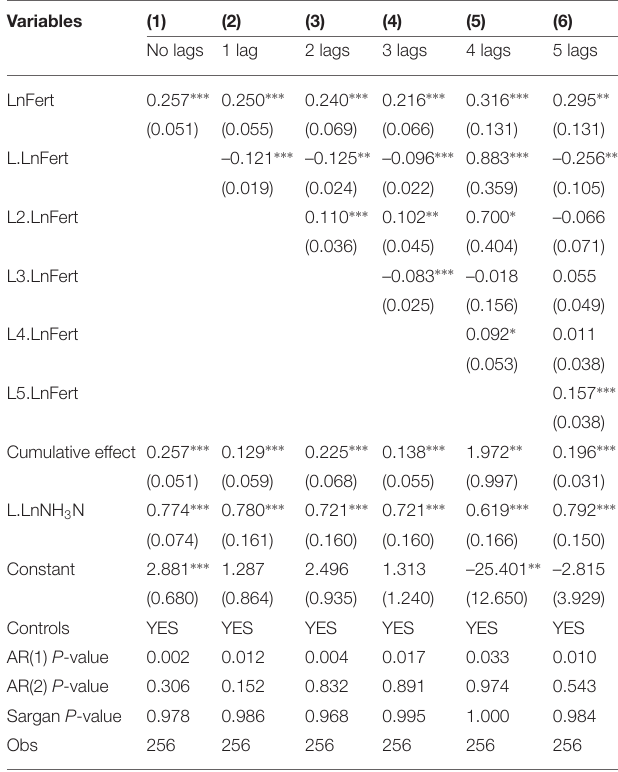
TABLE 5 | Threshold regression results. TABLE 6 | Long-term effects of fertilizer application on water